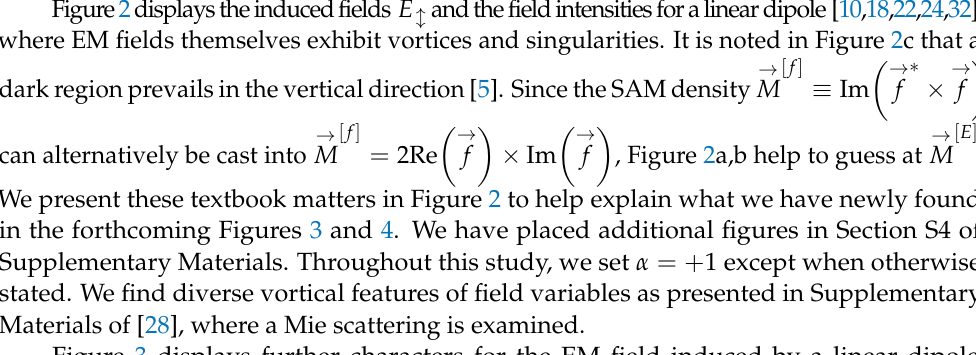
Figure2displaystheinducedfields